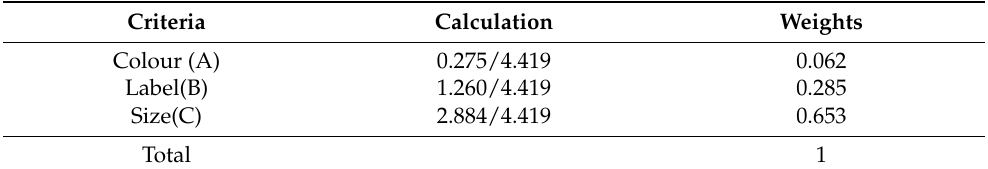
Table 12. The weights